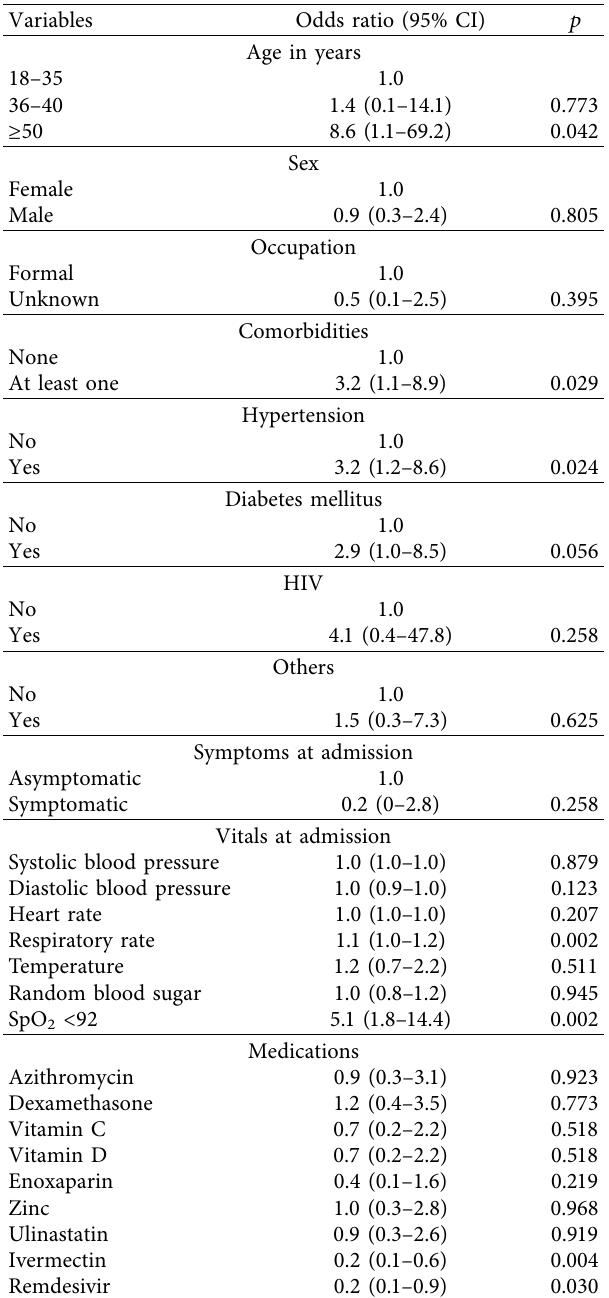
Table 5: Factors associated with mortality due to COVID-19 among the study